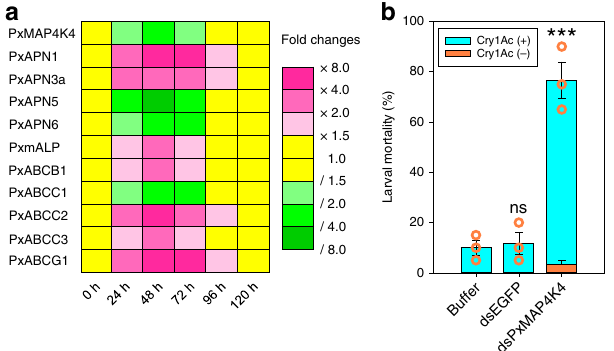
Fig. 4 Effect of PxMAP4K4 gene silencing on midgut gene expression and larval Cry1Ac susceptibility. a The effect of PxMAP4K4 gene silencing on expression of midgut genes at different periods. Gene expression level at 0 h post-RNAi was assigned a value of 1 for comparison, which are displayed as expression fold changes and color-coded according to the gradient. b Susceptibility to Cry1Ac protoxin (LC 10 , 1000 mg/L) in resistant NIL-R larvae post-RNAi. Data are presented as mean values ( a ) and mean values ± SEM ( b ), n = 3 biologically independent samples, *** p < 0.001, ns, not signi fi cant, one-way ANOVA with Holm – Sidak ’ s test was used for comparison. Source data are provided as a Source Data fi